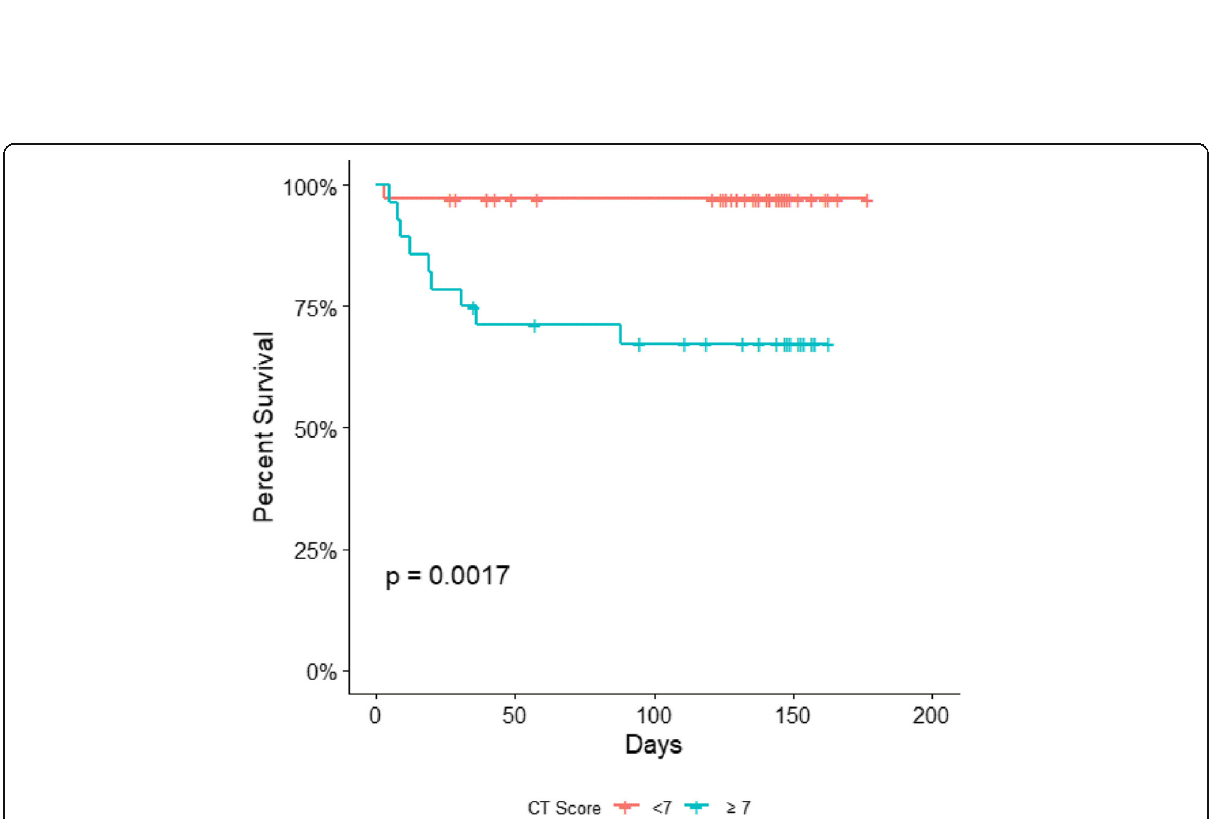
Fig. 5 Kaplan – Meier survival curve. Estimated survival rate comparison between COVID-19 patients with CT scores of < 7 and ≥ 7. Percentage survival is expressed on the y -axis, while time (days) of the observation period is expressed on the x